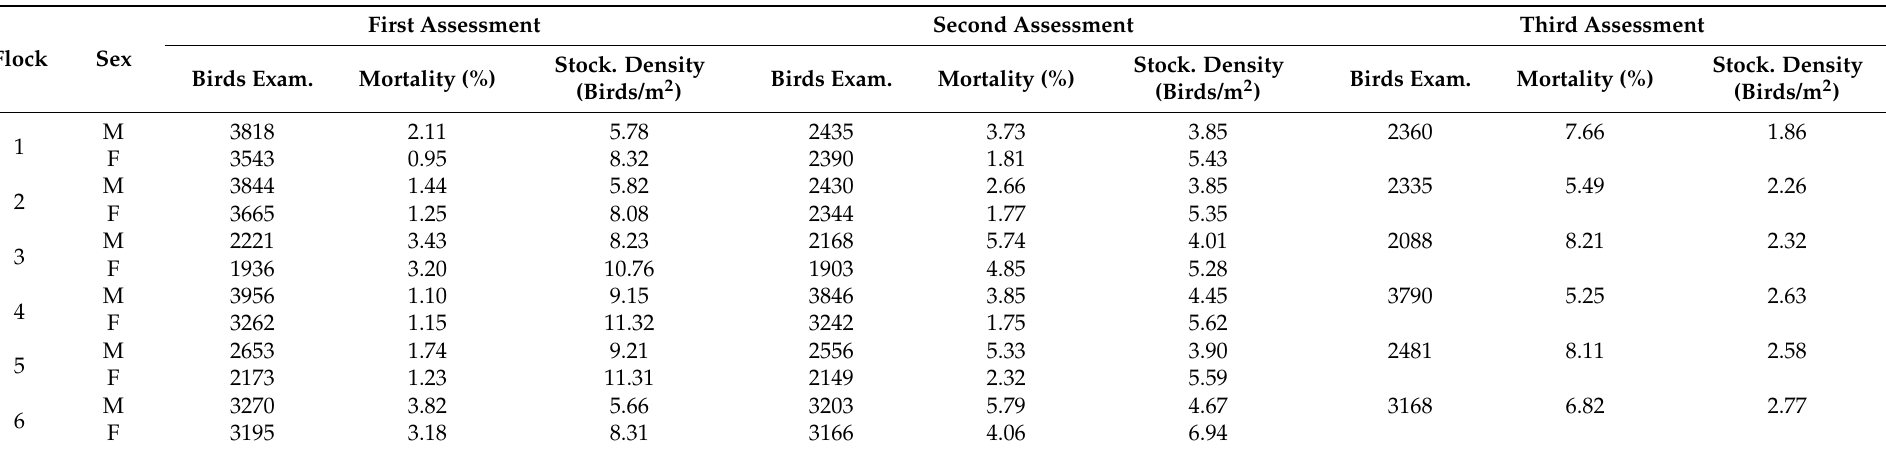
Table 2. Number of birds examined, cumulative mortality, and stocking density at each assessment. First Assessment Second Assessment Third Assessment Flock Sex Stock. Birds Exam.